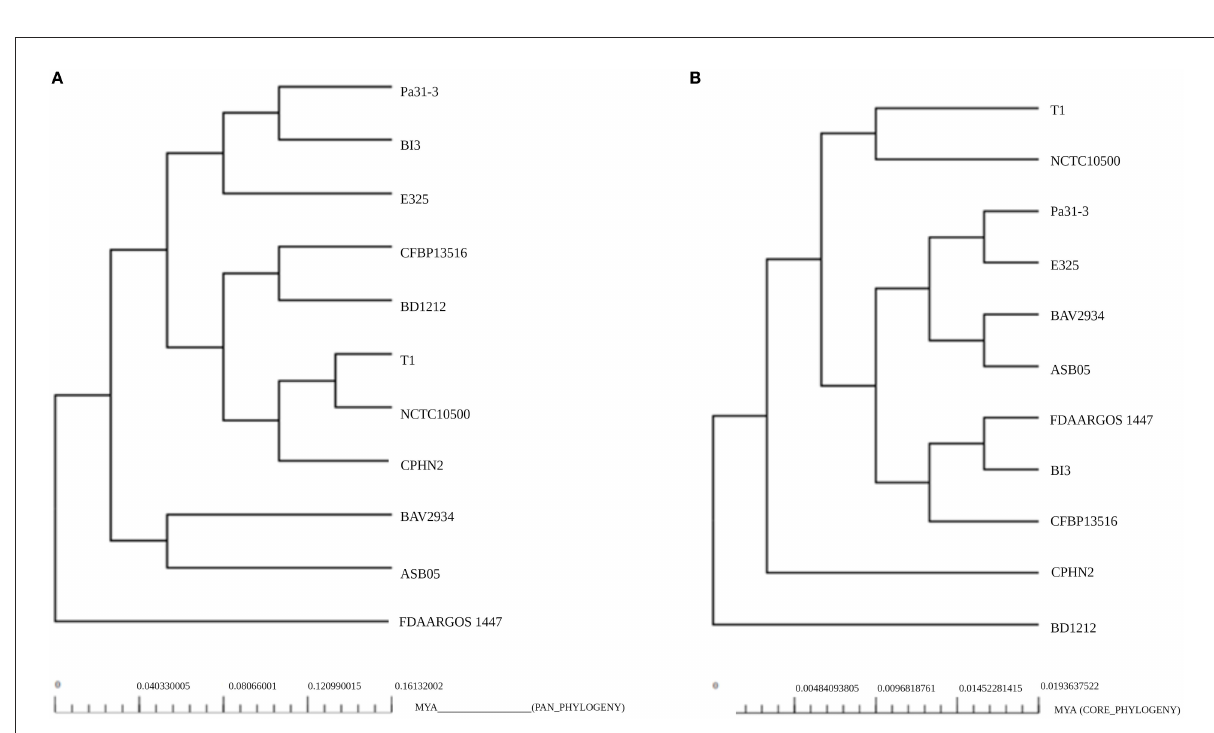
FIGURE5 Phylogeny of the P. agglomerans strains based on the analysis of (A) pan-genomes and (B) core genomes.